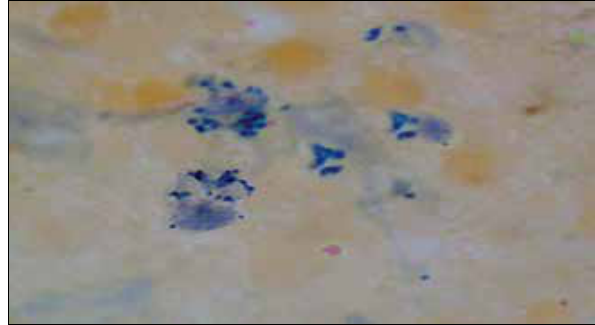
Figure-3: Bacteria phagocytosed by neutrophil showing opsonocytophagic index (×1000 magnification; leishman stain).